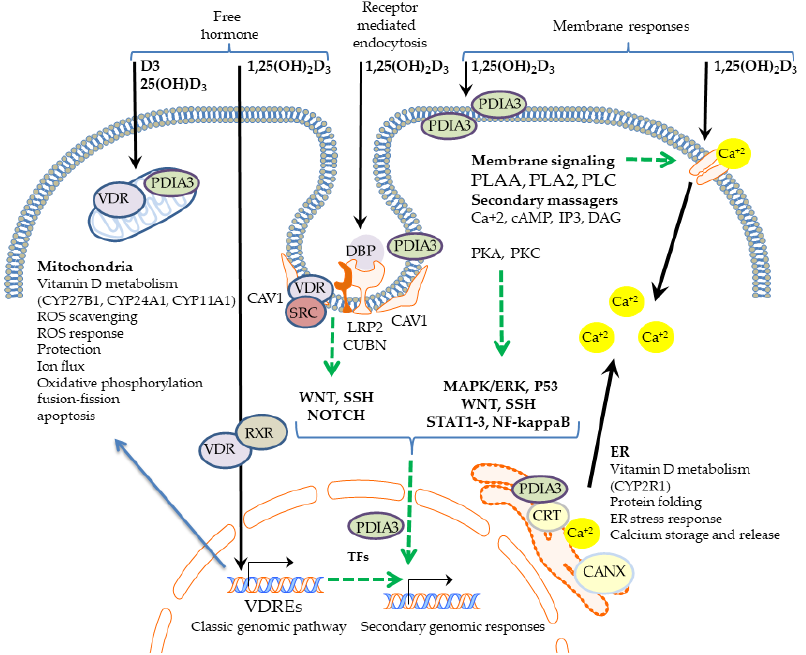
Figure 1. Vitamin-D-activated pathways. All secosteroids, including vitamin D 3 , 25(OH)D 3 , 1,25(OH) 2 D 3 , and other derivatives, enter the cell directly though the plasma membrane according to the free hormone hypothesis. Alternatively, 1,25(OH) 2 D 3 bound to DBP may be imported by the megalin/cubulin complex (LRP2-CUBN complex) via receptor-mediated endocytosis. Inside the cell, 1,25(OH) 2 D 3 binds the VDR-RXR complex, which is translocated into the nucleus and modulates the expression of targeted genes. Vitamin D metabolism takes place in the mitochondria, including activation of 25(OH)D 3 by CYP27B1, resulting in formation of 1,25(OH) 2 D 3 and inactivation of both metabolites by CYP24A1. In mitochondria, vitamin D may act as ROS scavengers, thus protecting the mitochondria from damage. Vitamin D metabolites may also directly influence ion transport, oxidative phosphorylation, and ROS response or may do so indirectly through the genomic pathway (blue arrow). PDIA3 mediates 1,25(OH) 2 D 3 -dependent membrane-signaling cascades. PDIA3 was detected on both sides of the cell membrane, on the endoplasmic reticulum, and in the cytoplasm, and its translocation to the nucleus was also postulated. PDIA3 mediates 1,25(OH)2D3-dependent activation of PLAA, PLA2, and PLC and the opening of Ca +2 and Pi (NaPi II a,c) channels. These result in the rapid accumulation of secondary messengers, including DAG, IP3, cAMP, and Ca +2 , followed by PKA, PKC, or CAMK2G activation and the alteration of several downstream targets, including MAPK pathways. VDR was found also to be colocalized with CAV1 and SRC in caveolae. Its membrane activity was linked with the downregulation of WNT, SSH, and NOTCH signaling pathways. Alone or together with VDR after stimulation with 1,25(OH) 2 D 3 , PDIA3 modulates the transcription factors NF-kappaB, STAT3, and P53. At the endoplasmic reticulum, PDIA3 — together with calreticulin (CRT) and calnexin (CANX) — facilitates protein folding. 1,25(OH) 2 D 3 , through VDR transcriptional activity, induces several transcription factors (TFs) which are involved in secondary genomic responses to this multipotent hormone.